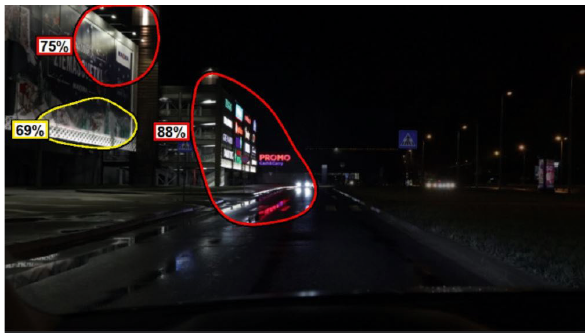
Figure 11. Driver’s view at night by 3M VAS photography